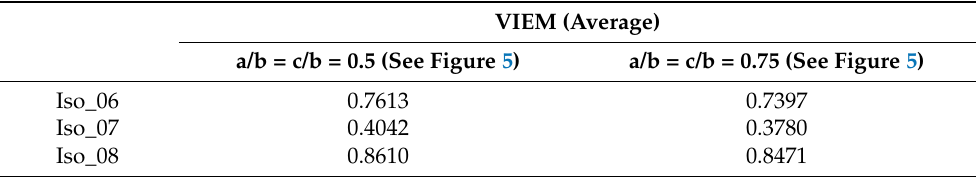
Table 12. Normalized tensile stress component ( σ xx / σ o xx ) within the isotropic prolate spheroidal inclusion due to uniform remote tensile loading ( σ o xx ).